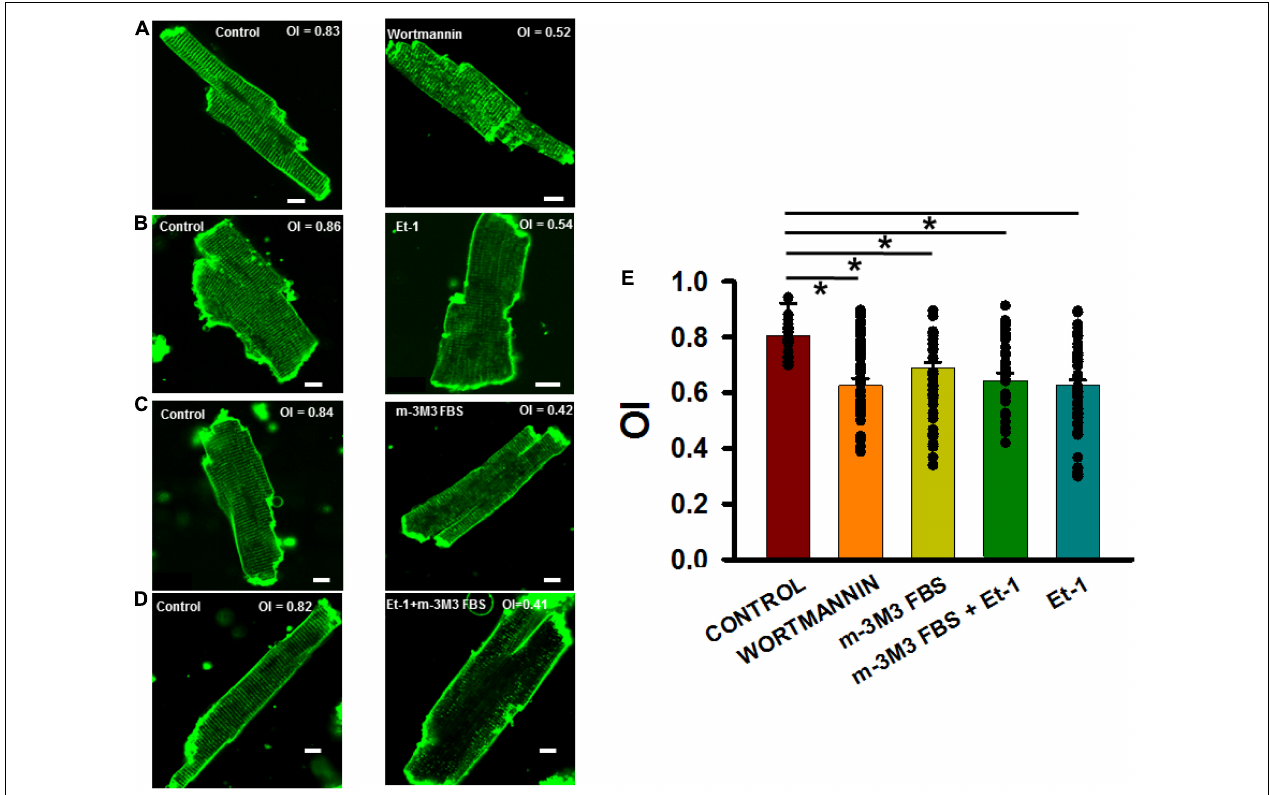
FIGURE 5 | PIP2 depleting agents adversely affected organizational index (OI) of TTs in isolated adult rat ventricular myocytes. (A–D) 2-D images of control (left panels) and treated (right panels) myocytes. (E) Summary of OI changes untreated cells (35 myocytes in 3 rats) and after treatment with wortmannin (15 µ mol/L, 2 h, n = 35/3), m-3M3FBS (30 µ mol/L, 3 h, n = 37/5), and Et-1(400 nmol/L) + m-3M3FBS (30 µ mol/L, 45 min, n = 35/4) and Et-1 (400 nmol/L, 6 h, n = 54/4). ∗ p < 0.05 using Dunn’s test following a one-way ANOVA performed on all cells. Pixel size was 0.45 µ m with the pinhole adjusted to Airey units =